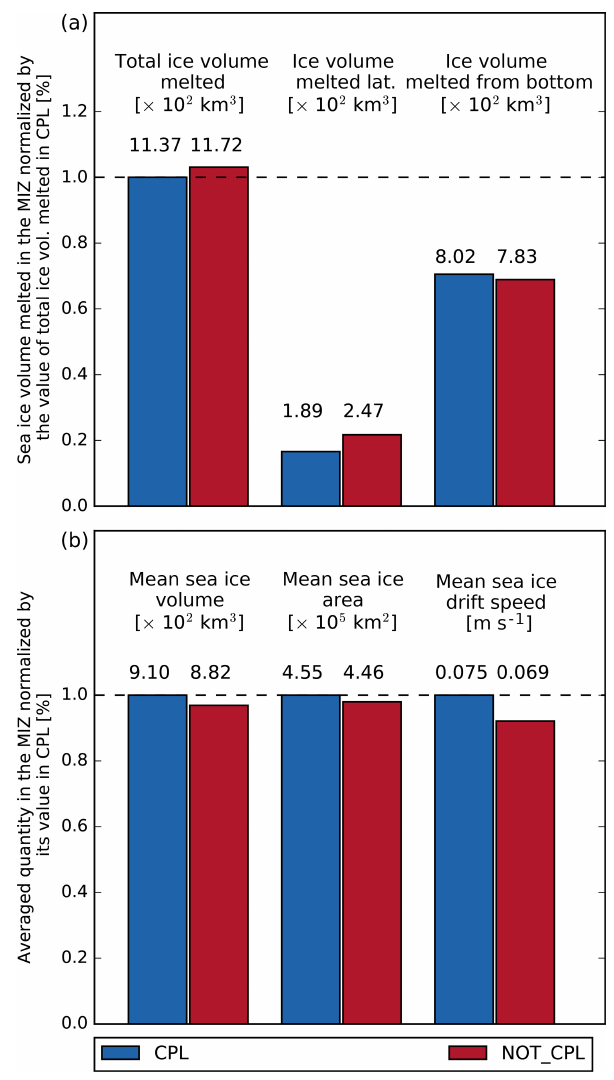
Figure 8. (a) Sea ice volume melted (in 10 2 km 3 ) integrated over the MIZ and over the period between 4 August and 9 Septem- ber 2010 in the CPL and the NOT_CPL simulations. Here the MIZ is defined as the region where 0 < (cid:104) D max (cid:105) < 700m in the CPL run. The contributions from lateral melt and bottom melt to the total melt for both simulations are also represented. (b) Mean sea ice volume (in 10 2 km 3 ), area (in 10 5 km 2 ) and drift speed (in ms − 1 ) in the MIZ over the same period. Values for each simulation are found above their associated